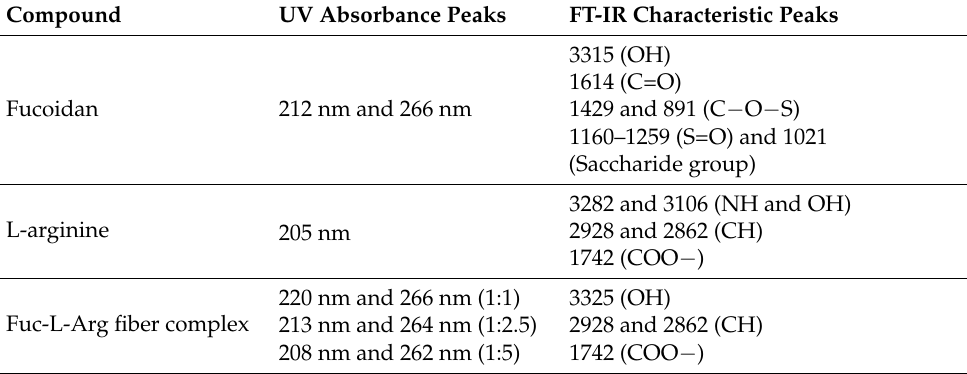
Table 1. UV absorbance and FT-IR characteristic peaks in Fucoidan, L-Arginine, and Fuc-L-Arg fiber